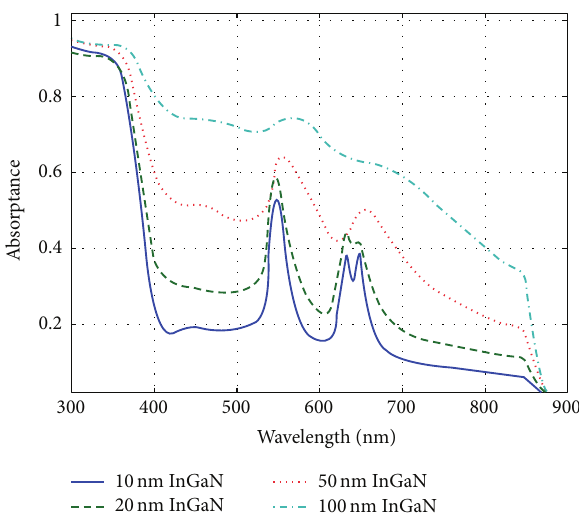
Figure 5: Calculated absorptance spectra for optimized GaN-capped solar cell structures with 10nm (blue), 20 nm (green dashed), 50 nm (red dotted), and 100nm-thick (light blue dot-dashed) InGaN layers.